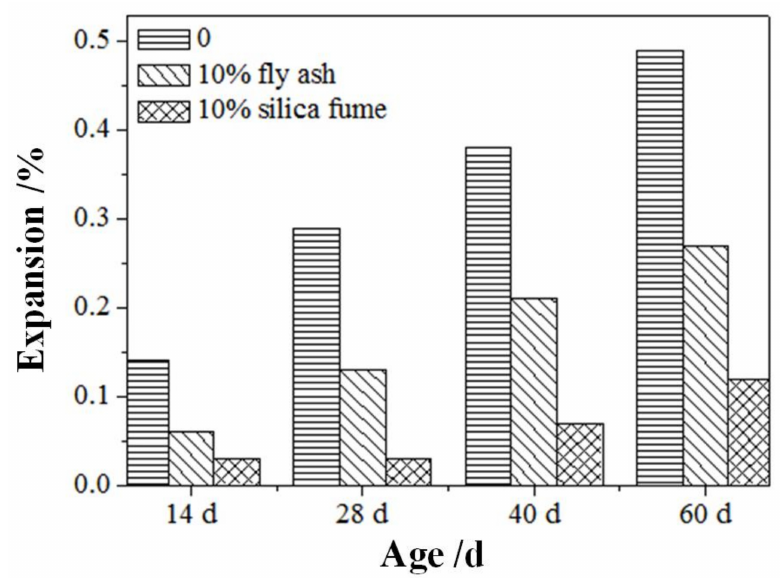
Figure 9. Expansion inhibition effects of the mortar bar for the fly ash and silica fume of 10%.